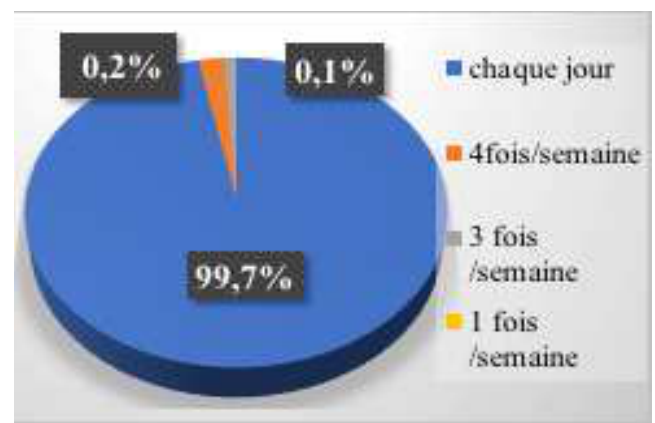
Fig.4. Fréquence (quotidienne et hebdomadaire) d’utilisation des dispositifs technologiques. Fig. 2. Proportions globales de l’échantillon selon l’âge.